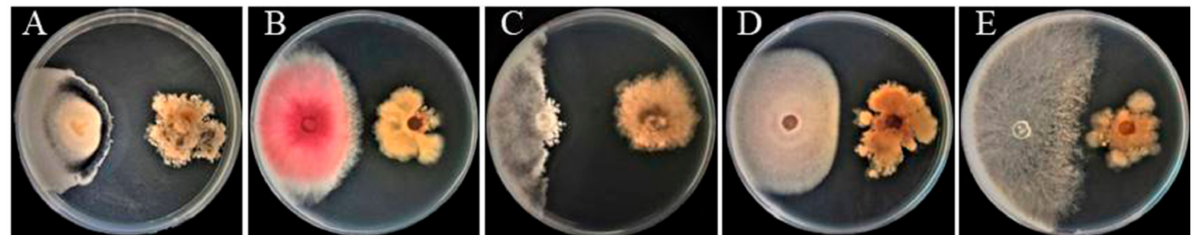
Figure 1. Endophyte F5 inhibits the growth of five pathogenic fungi’s mycelia. Inhibitory effect on ( A ) V. dahlia, ( B ) F. graminearum , ( C ) B. cinerea , ( D ) F. oxysporum , ( E ) R. solani .